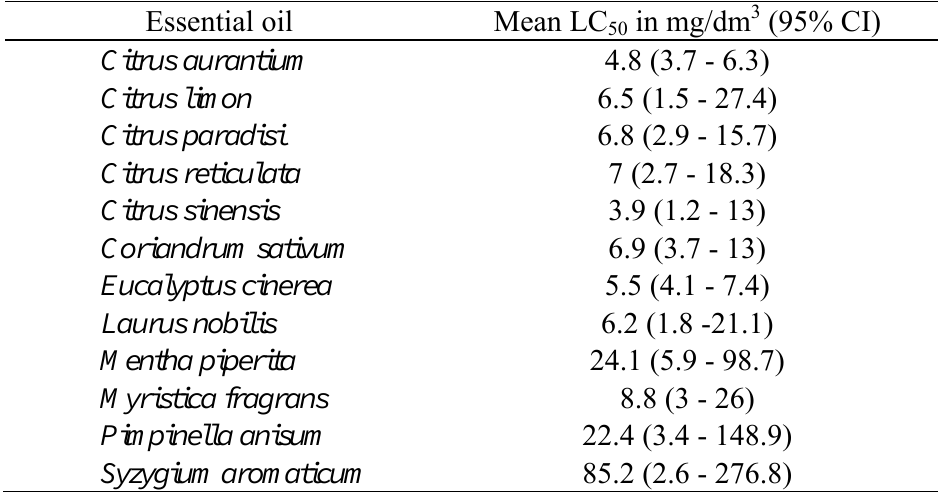
Table 2. LC s of essential oils against Musca domestica. 50